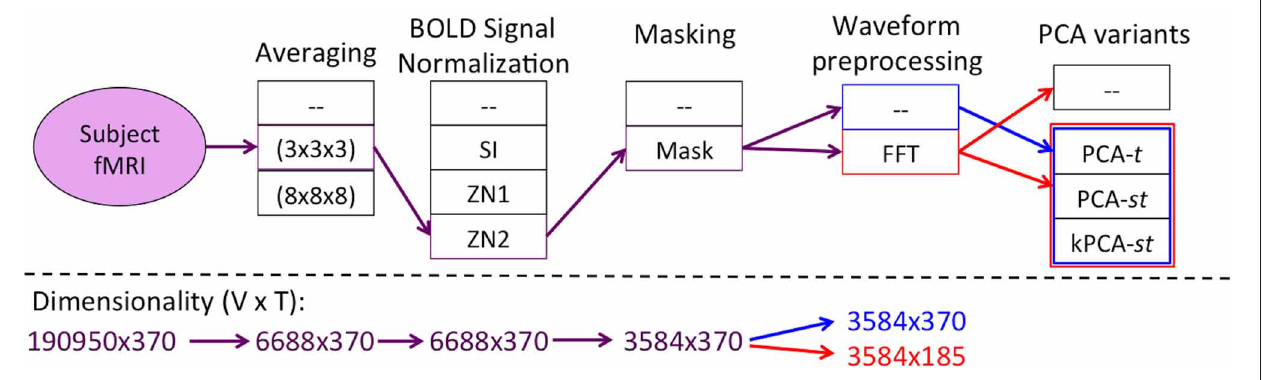
FIGURE 2 | Flow of the “Feature Creation/Selection” component of our diagnostic system, where the red and blue lines denote the processes with and without FFT as a preprocessing step, respectively. The PCA variant step involved developing the respective variant’s data matrix and